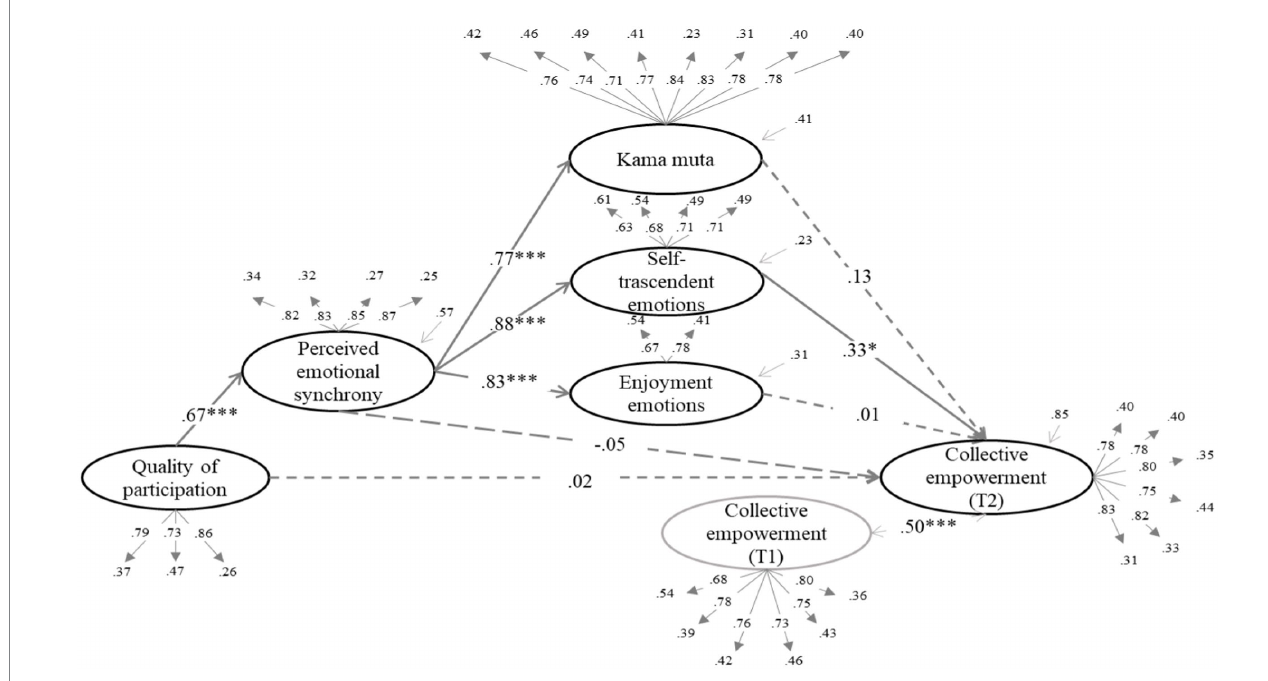
FIGURE 6 Perceived emotional synchrony and emotions as mediators of the effect of quality of participation on collective empowerment controlling for pre- participation scores. Model fit: χ 2 = (404, 484) = 1237.669, p < 0.001, CFI = 0.912, TLI = 0.904, RMSEA = 0.062. SRMR =